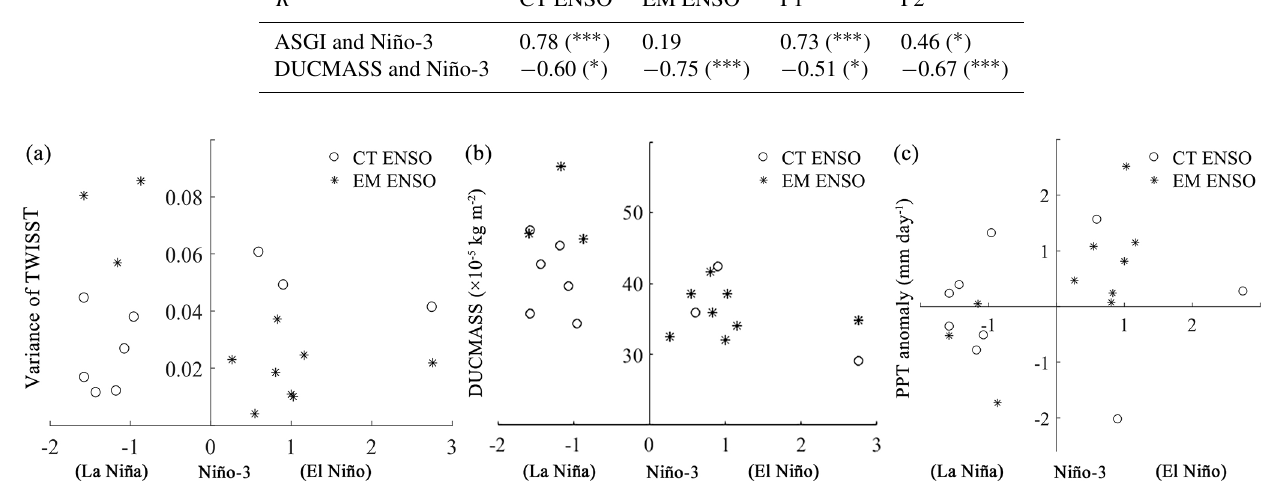
Figure 17. Scatter diagram between (a) variance of the monthly TWISSTA from ( − 1) September to (0) May, (b) DUCMASS, and (c) the PPT anomaly and Niño-3 index separately for continuing (CT) and emerging (EM)